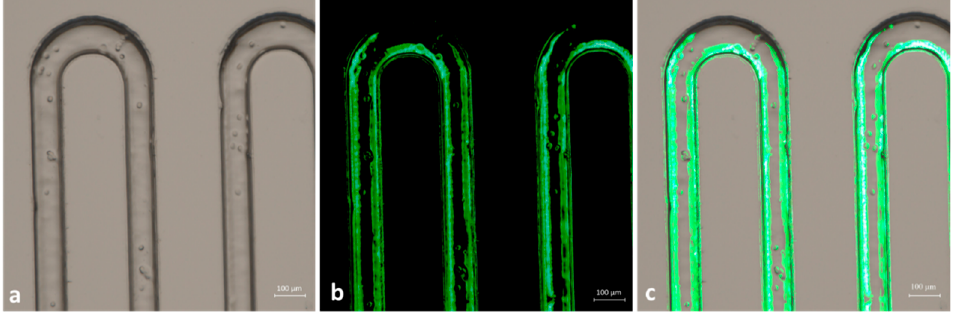
Figure 9. Identification of OECM fixed cells with anti-EpCAM antibody and secondary FITC-labeled antibody. ( a ) Bright-field acquisition of cells; ( b ) green fluorescent acquisition; ( c ) merged image of (a) and (b).